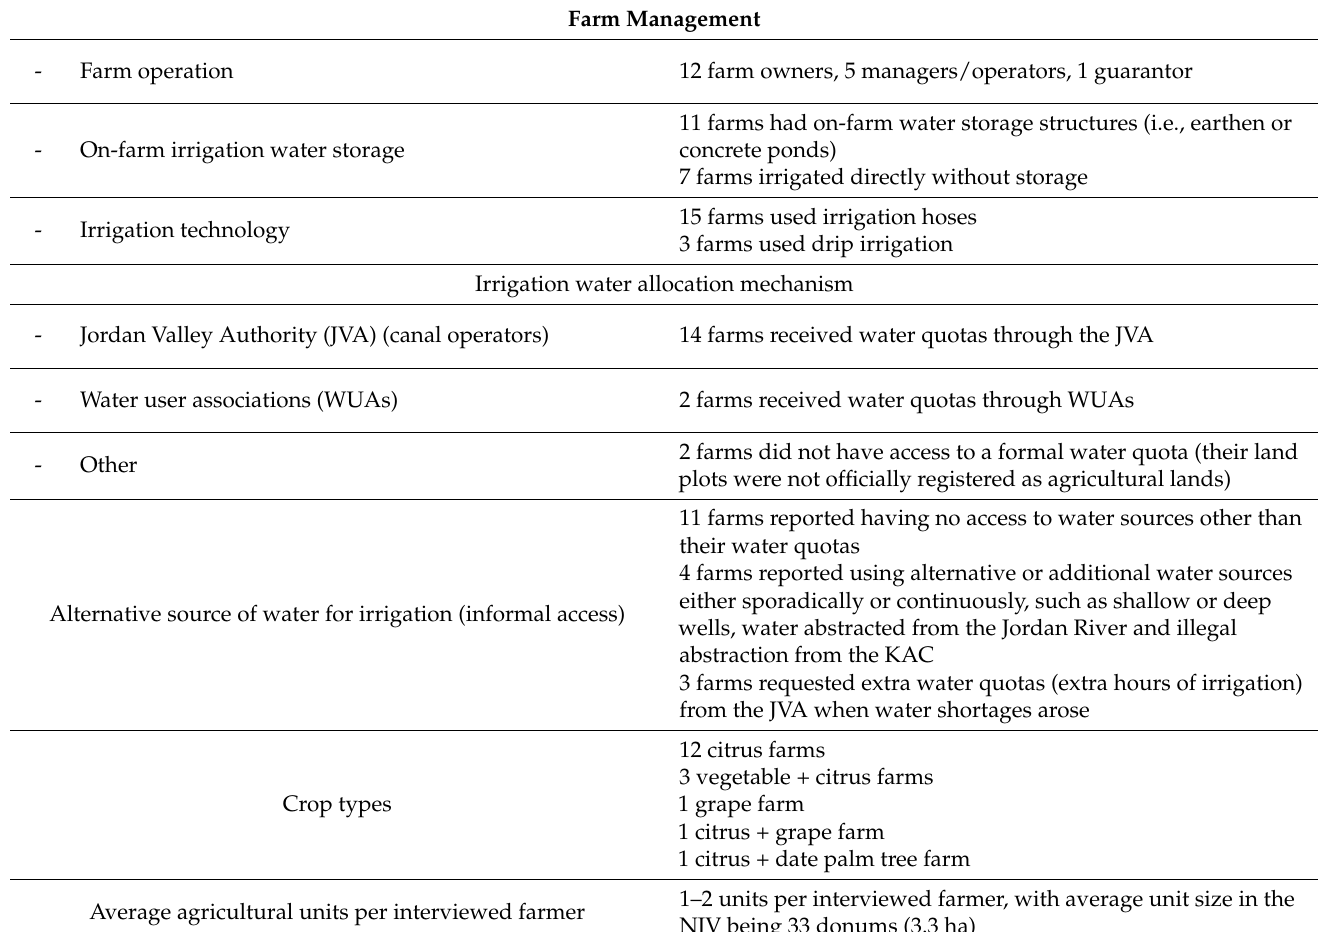
Table 2. Characteristics of the farms in the Northern Jordan Valley (NJV) randomly selected for this study.